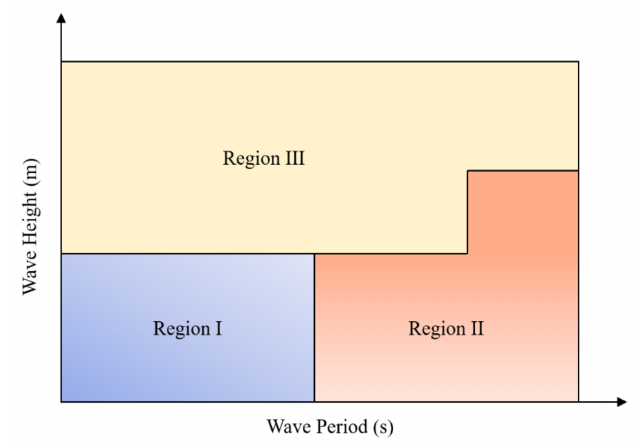
Figure 6. Partitioning of sea states based on fundamental limits.